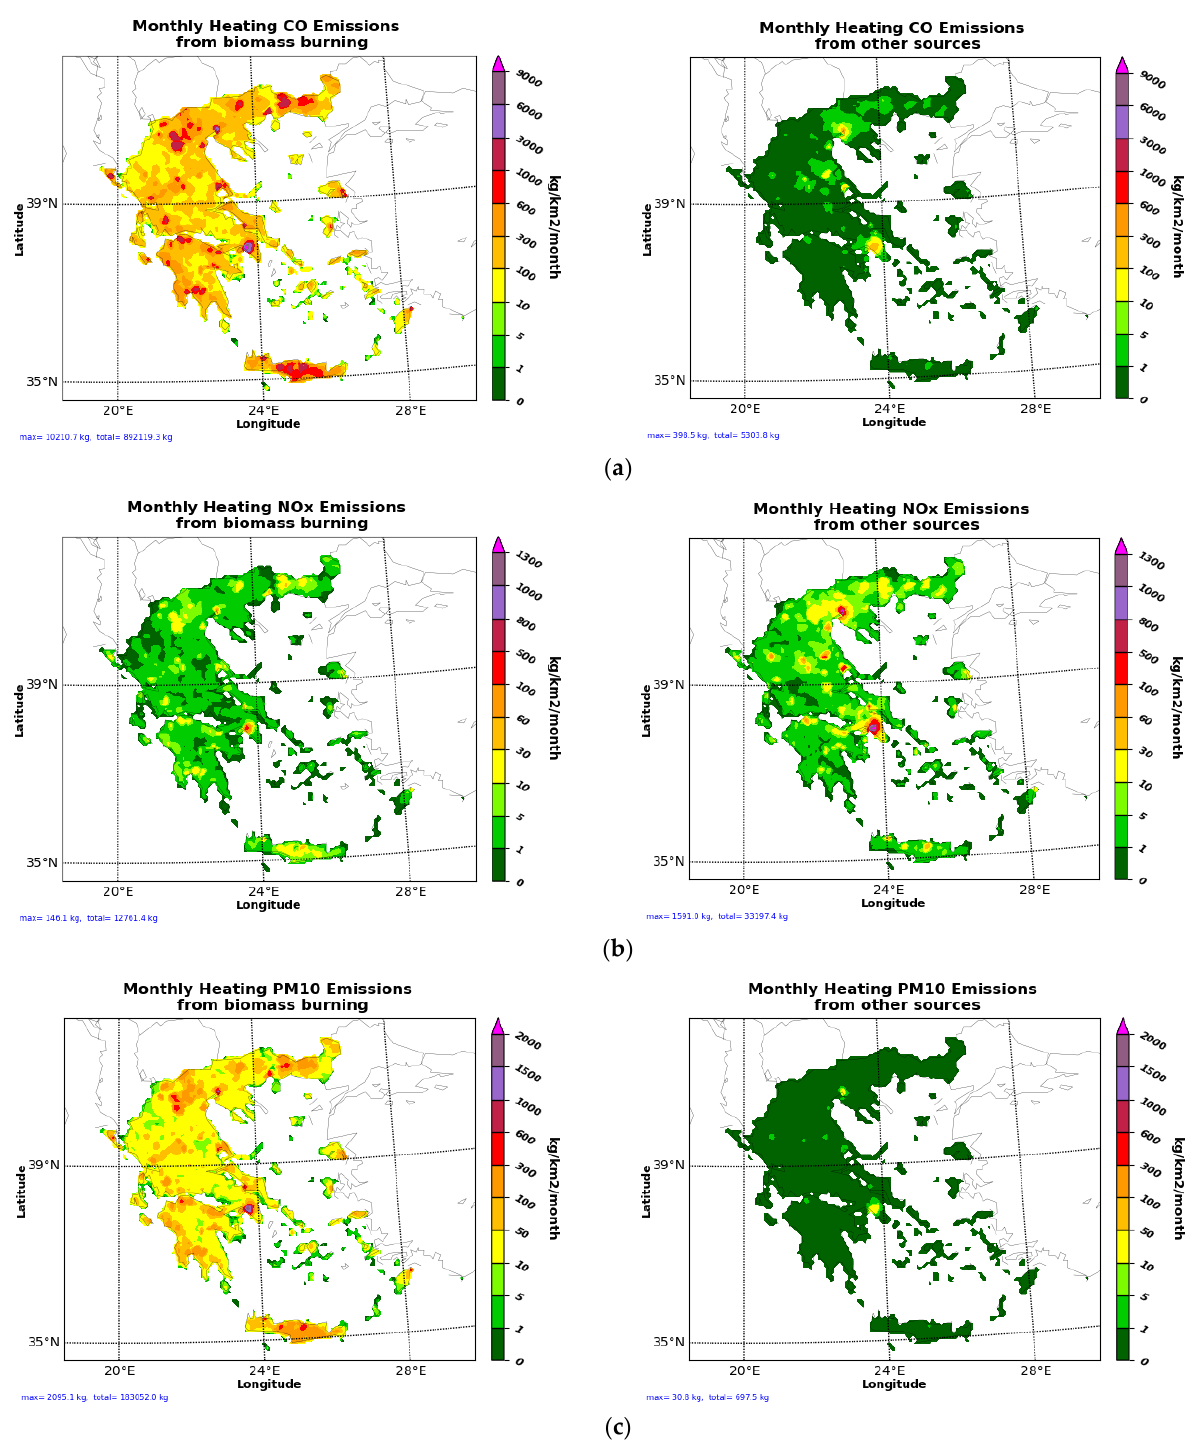
Figure 6 . Spatial distribution of total monthly emissions (kg/km 2 ) of ( a ) CO, ( b ) NO x and ( c ) PM10 from biomass burning (wood/biomass) (left) and other sources (oil, natural gas) (left) over Greece (6 × 6 km 2 grid) for January 2015.